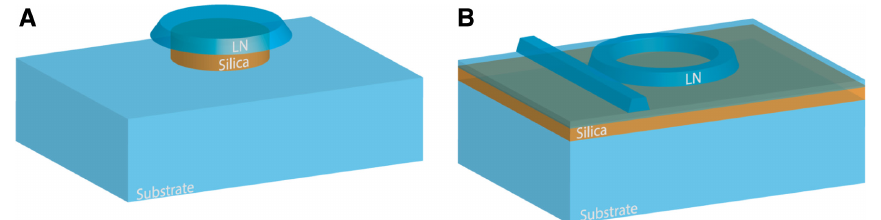
Figure 9: Schematic diagrams of LNOI resonant cavities.